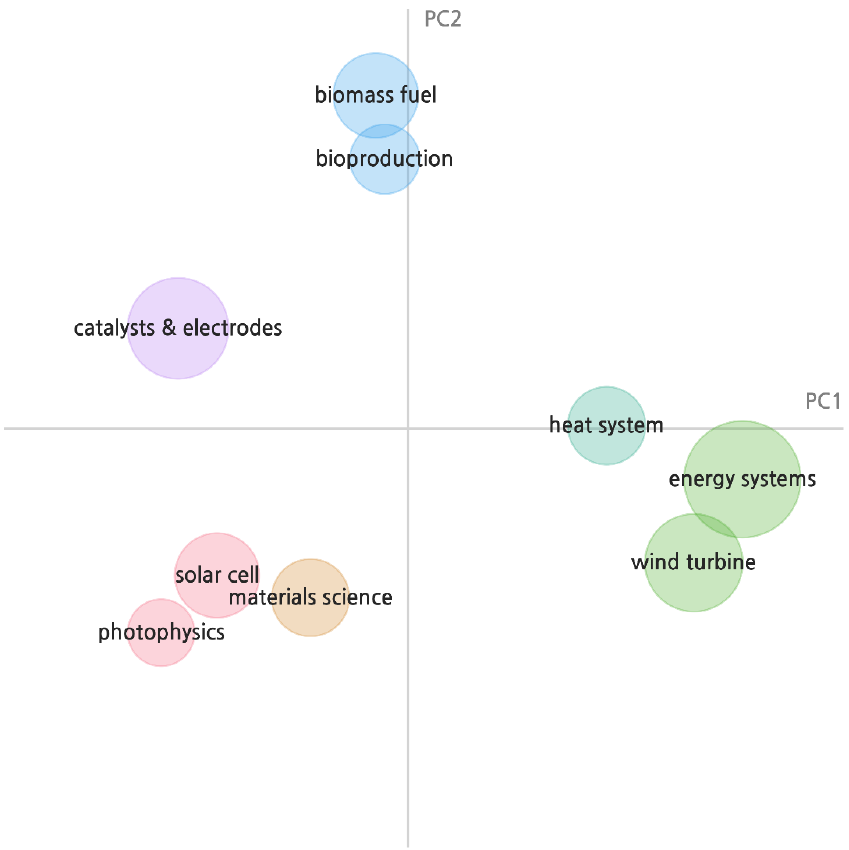
Figure 8. Intertopic distance map of topics on the PCA space.